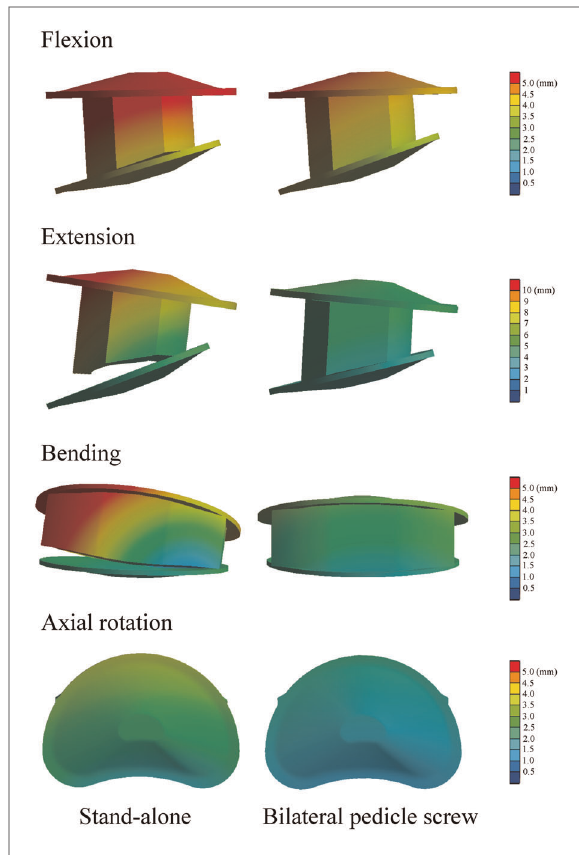
FIGURE 5 Nephograms for BEPs and the OLIF cage under different loading